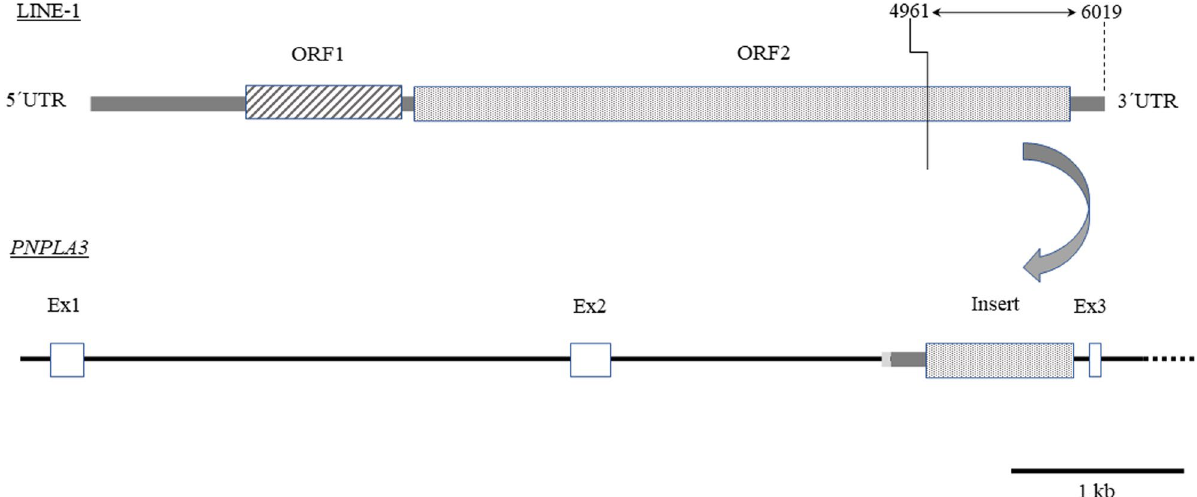
Figure 2. Structure of Insertion. The typical LINE-1 element consists of two open reading frames (ORF, hatched and dotted boxes) and 5 ′ and 3 ′ untranslated regions (UTR, thick gray line). The extent (horizontal double arrow, numbers indicate position in the “LINE-1 reference” AF148856.1), position, and orientation of the LINE-1 insert in the second intron of PNPLA3 is shown. 5 ′ UTR and introns of PNPLA3 are shown as a black line (the dotted line represents 3 ′ portion of PNPLA3, which is not shown), and exons as white boxes. The Insert consists of a short filler sequence, 3 ′ UTR (thick light and dark gray lines, respectively), and part of ORF 2 (dotted box) of the LINE-1 element.